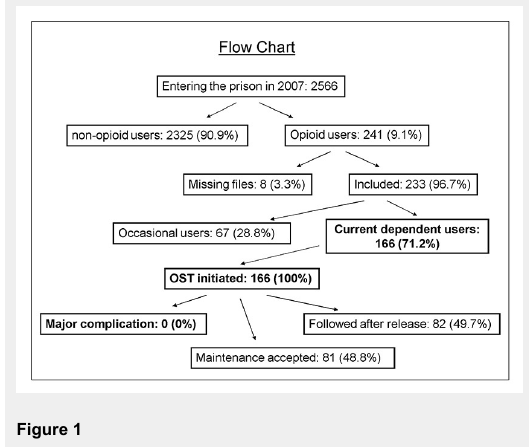
Table 1: Summary of the principles of opioid substitution treatment at Champ-Dollon in Geneva, following the Swiss Society of Addiction Medicine (SSAM) and the World Health Organization (WHO). Treatment principle SSAM Indication for OST Preferred treatment option other than Methadone